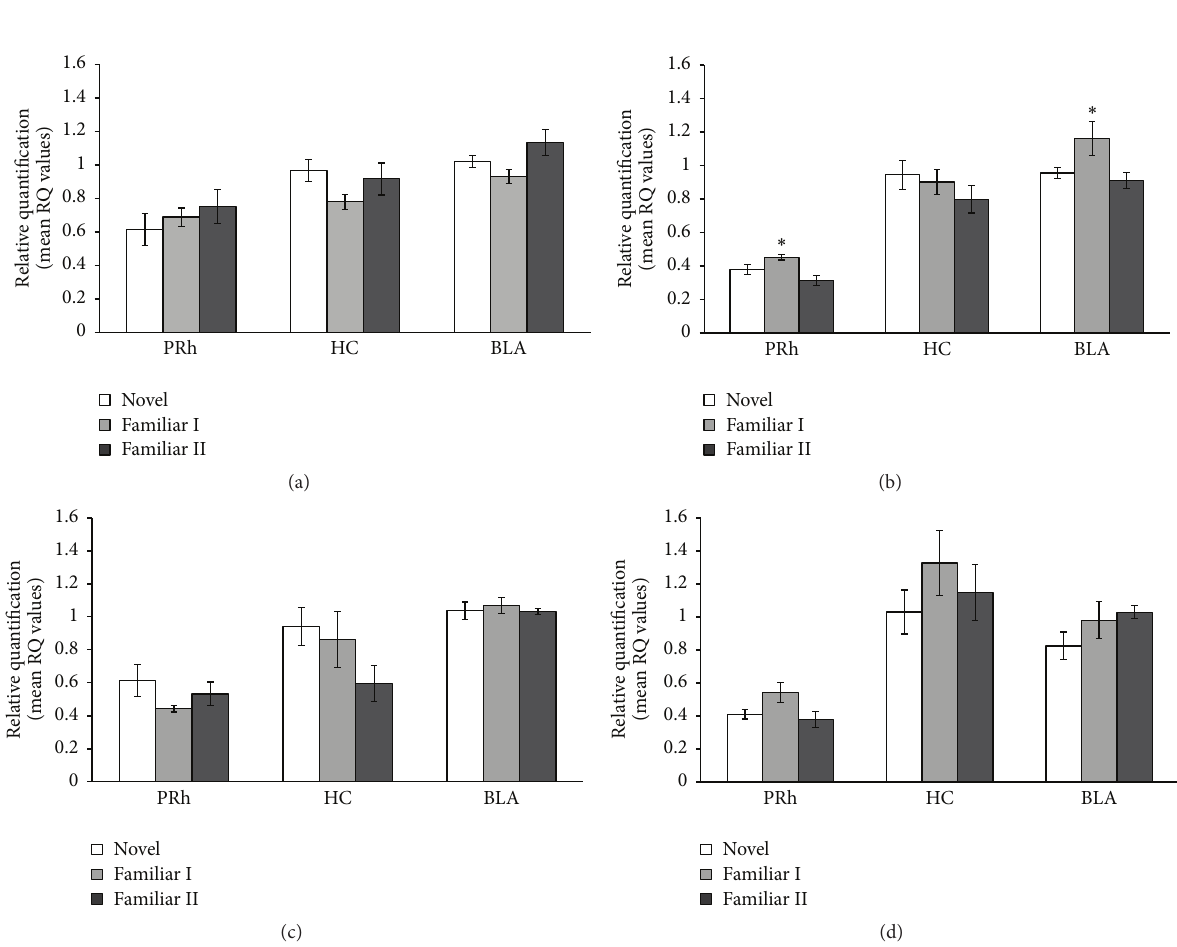
Figure 2: Fold change values for the genes GluR2 (a), NSF (b), Homer 1 (c), and Narp (d) in PRh, HC, and BLA of novel, Familiar I, and Familiar II groups. ∗ versus Familiar II group ( 𝑝 < 0.05